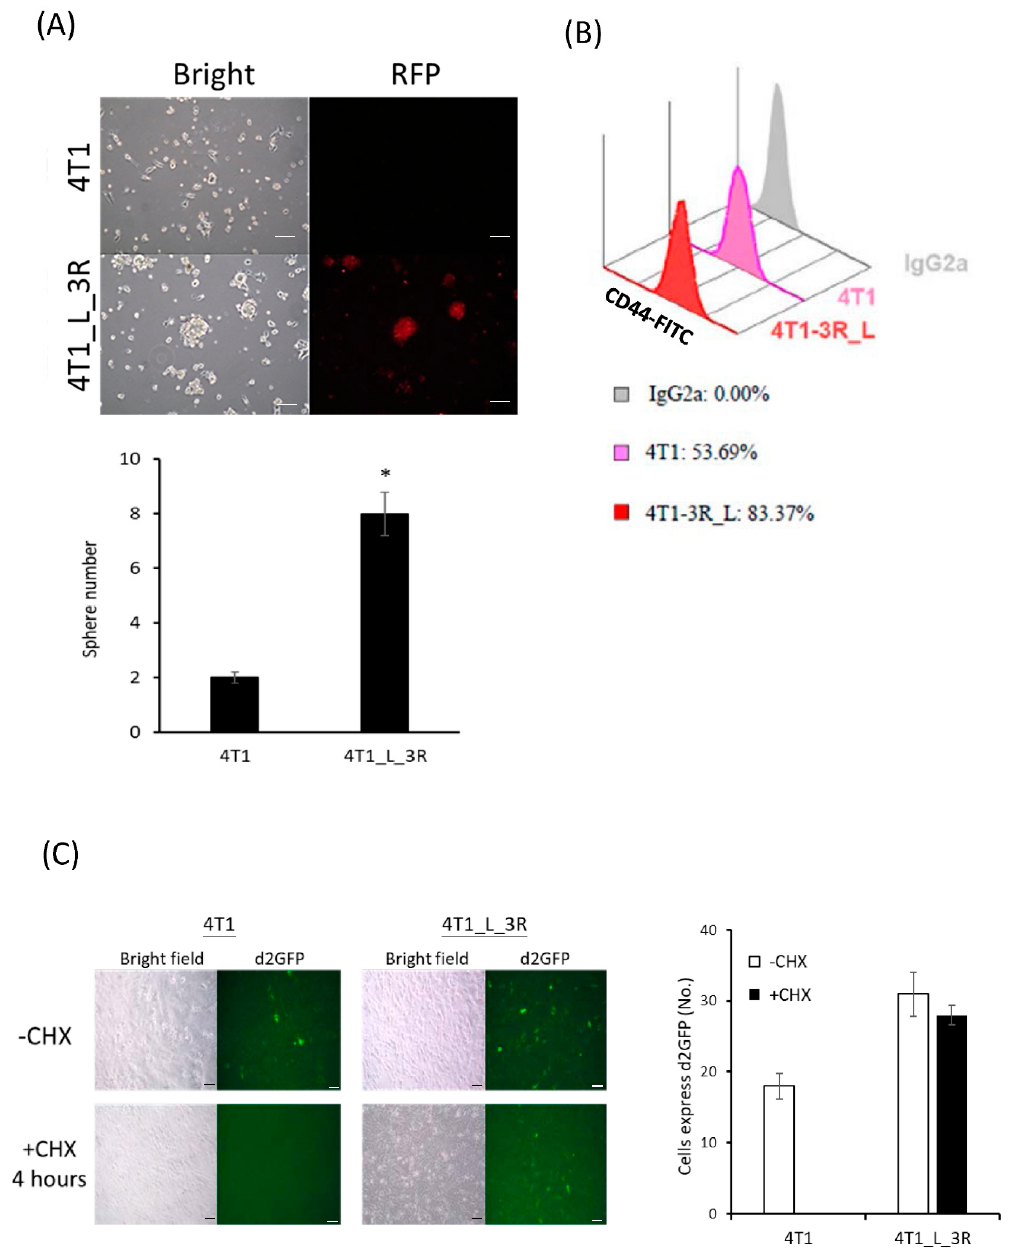
Figure 2. Characterization of liver-metastatic 4T1 cells for tumor-initiating properties. ( A ) Comparison of sphere-forming capacity between parental 4T1 cells and 4T1_L_3R cells. RFP expression remained detectable in the latter cells; * p < 0.05. ( B ) Flow cytometric analysis of CD44 marker expression in parental 4T1 cells and 4T1_L_3R cells. ( C ) Comparison of the degradation rate of d2GFP between parental 4T1 cells and 4T1_L_3R cells after treatment with cycloheximide (CHX) (50 µ g / mL) for 4 h. Scale bar = 100 µ